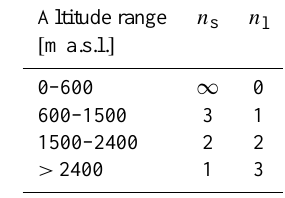
Table 2. Thresholds of the number of snow (land) observations (fol- lowing the first one) required for identifying the beginning of the snow (land) season in step 5. The threshold is set per altitude ranges.